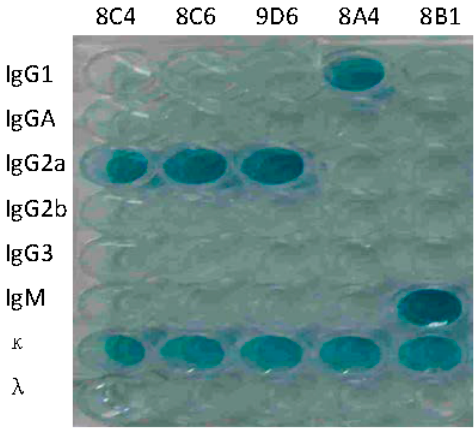
Figure 2. Isotype identification of prepared monoclonal antibodies (mAbs). mAbs 8C4, 8C6, 9D6, 8A4, and 8B1 are labeled on the top of the plates. Table 1. Characterization of seven mAbs direct against swine/GD/LM/04. mAb Titers of ELISA